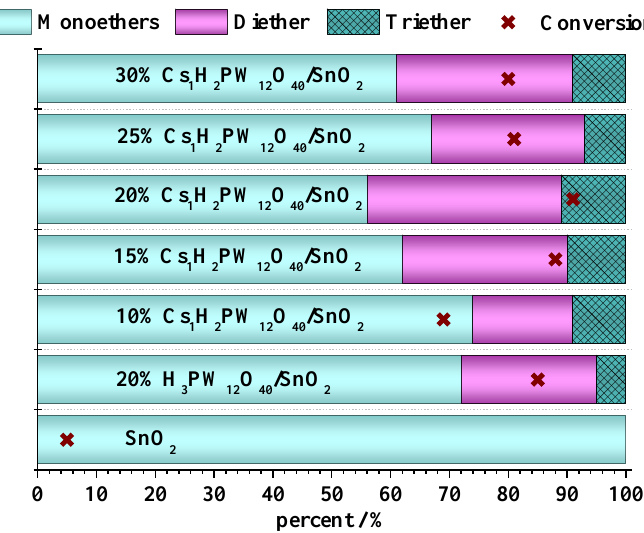
Figure 20. Impact of variation of CsH 2 PW 12 O 40 loading on the SnO 2 in the conversion and selectivity of glycerol and etherification with tert − butyl alcohol (adapted from ref. [63]. Reaction conditions: glycerol (1.84 g); tert − butyl alcohol (17.84 g); catalyst weight (0.5 g); reaction temperature (373 K); and reaction time (1 h).